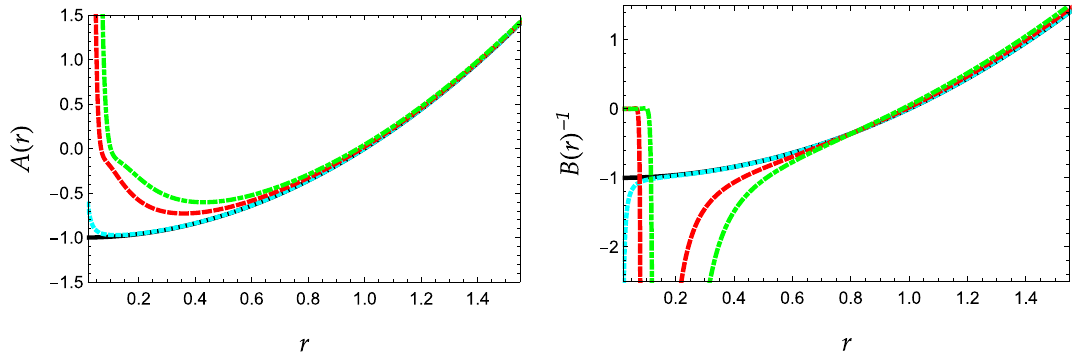
G 0 = 1 , M 0 = 1 and (cid:9) 0 = 1. The color code is as follows: (i) solid black line, for ξ = 0, (ii) dotted blue line, for ξ = 0 . 010, (iii) dashed red line, for ξ = 0 . 100, (iv) dot-dashed green line, for ξ = 0 . 150